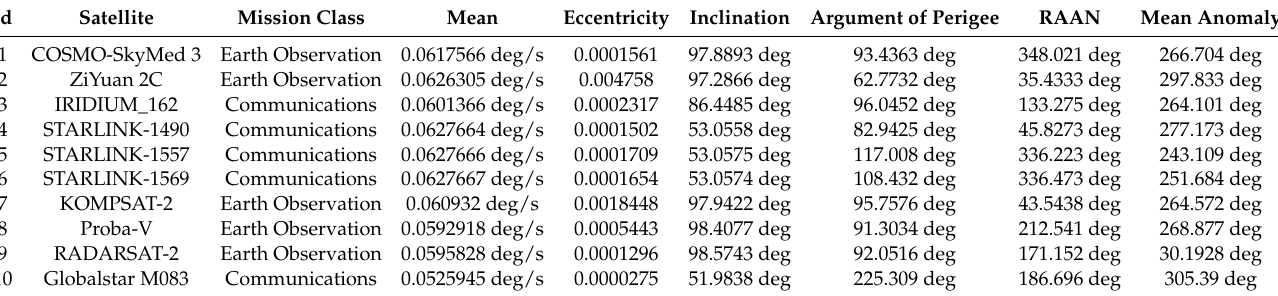
Figure 8. Two-dimensional trajectory of satellite. Table 3. Satellites parameters in the simulation